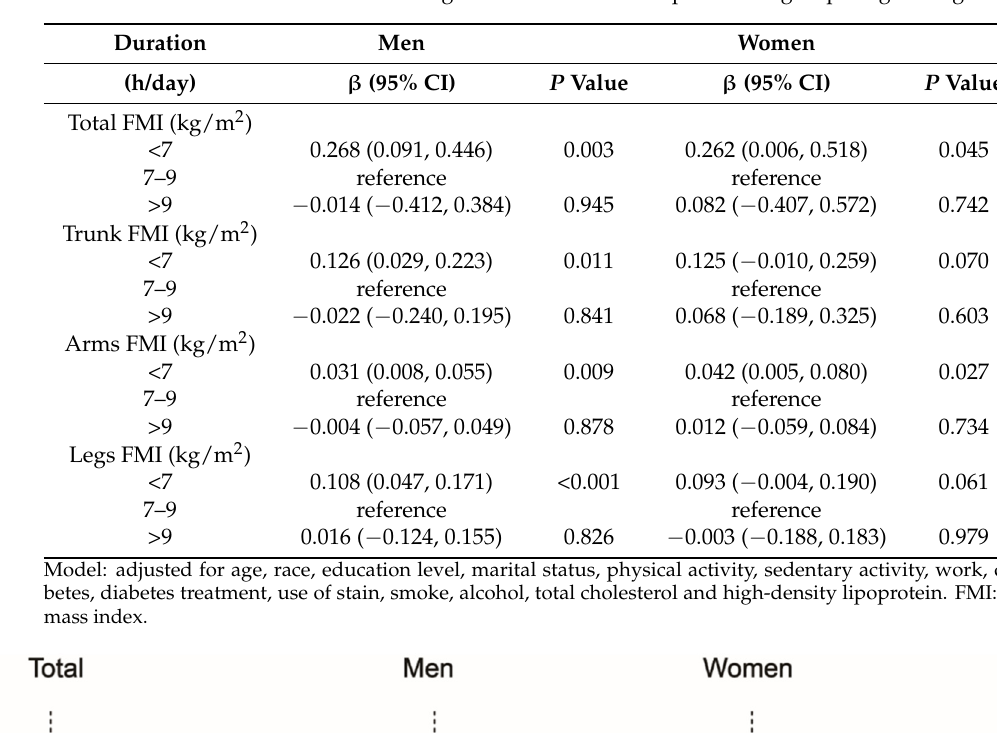
Table 3. Association between different regional fat mass and sleep duration groups in gender groups.